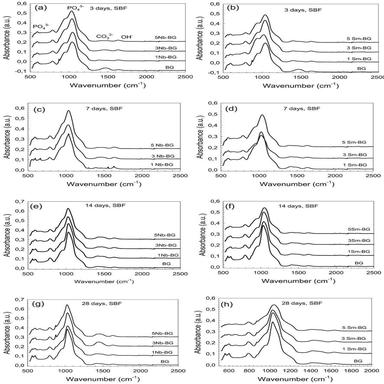
FTIR spectra of the Nb5+(left column) Sm3+ (right column)-containing bioactive glass powders treated in SBF for (a),(b) 3 days; (c),(d) 7 days; (e),(f) 14 days; (g),(h) 28 days.